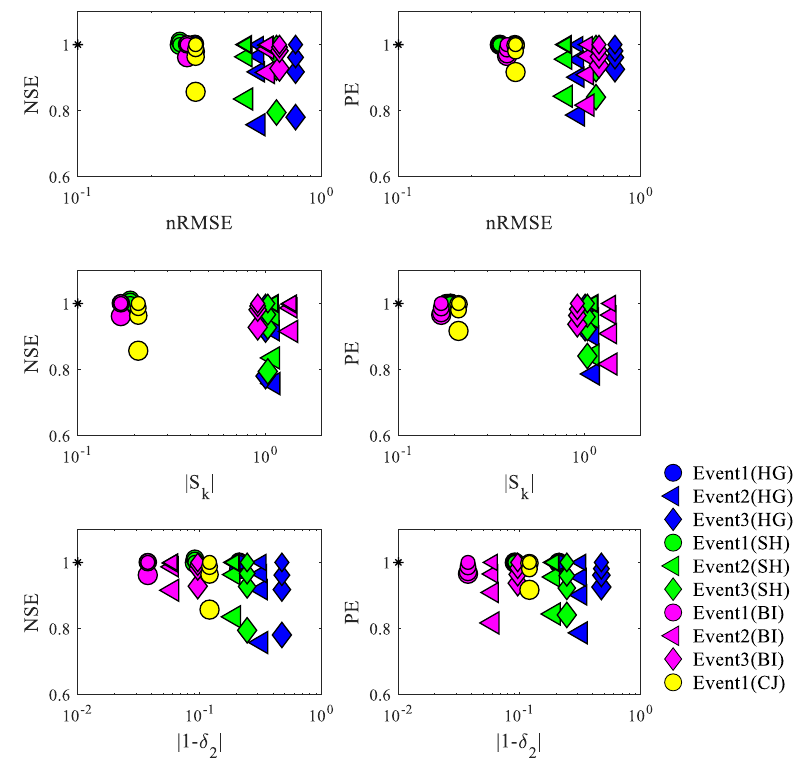
Figure 10. Relationship between variation of NSE and PE by 𝑇 𝑟 , and nRMSE, 𝑆 𝑘 , and 𝛿 2 (with 𝐿 𝑟 = L r = 250 m). Symbol size is proportional to the T r from 10 min to 60 250 m ). Symbol size is proportional to the 𝑇 𝑟 from 10 min to 60 min.